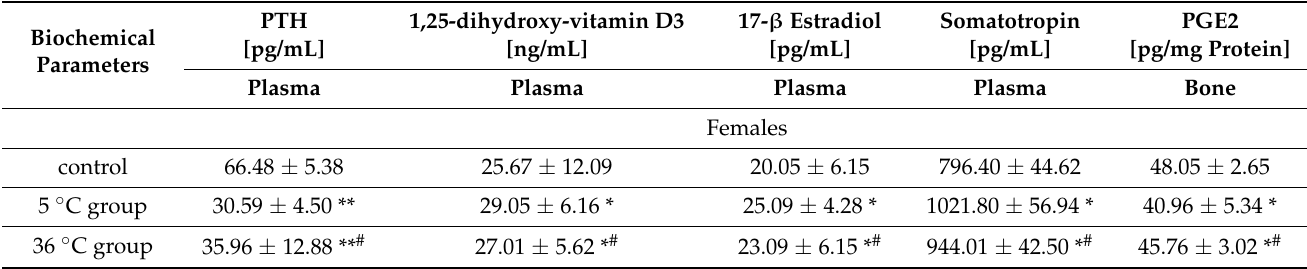
presented as means ± standard deviations. * p < 0.05 level of statistical significance vs. the control group (Mann–Whitney U test). ** p < 0.005 level of statistical significance vs. the control group (Mann–Whitney U test). # p < 0.05 level of statistical significance against the 5 ◦ C group (Mann–Whitney U